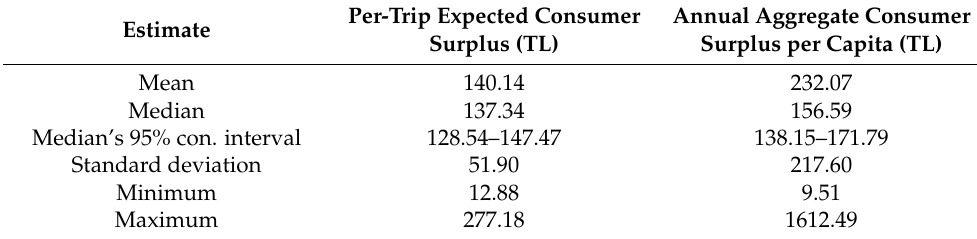
Table 4. Economic value estimates.